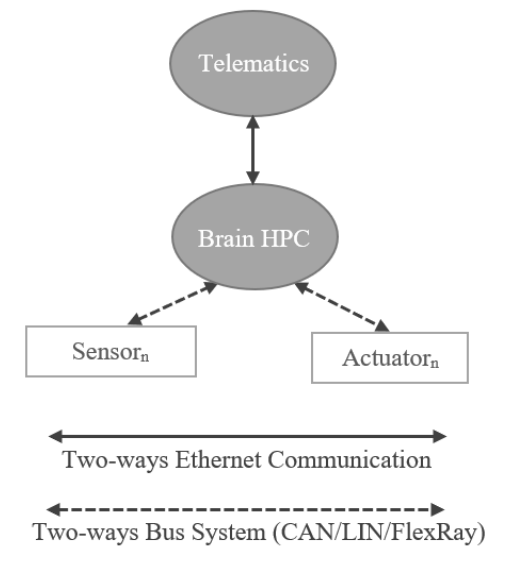
Figure 10. Representation of One-Brain E/E